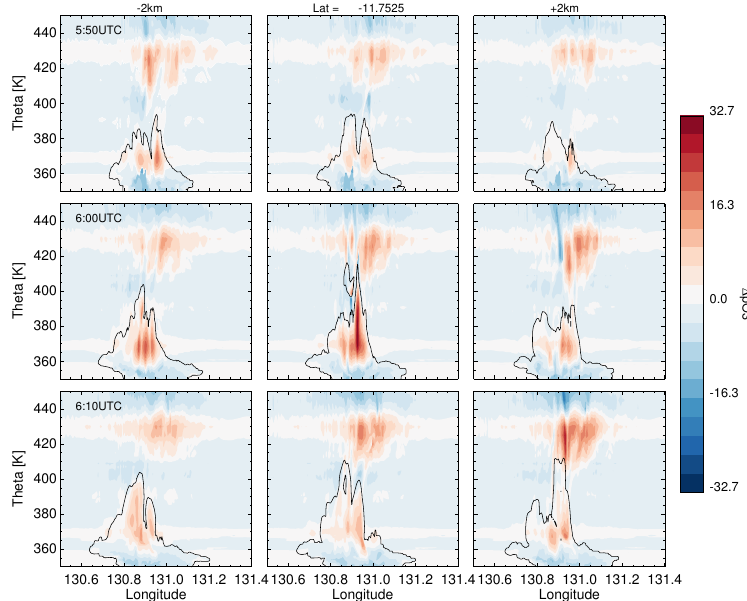
Figure 10. Cross sections of p O 3 difference from the initialisation profile ( (cid:49)p O 3 ). By shifting the cross section 2km to the south/north (right/left) and 10min prior/later (upper/lower panels), the variability of the cloud and the (cid:49)p O 3 field becomes visible.